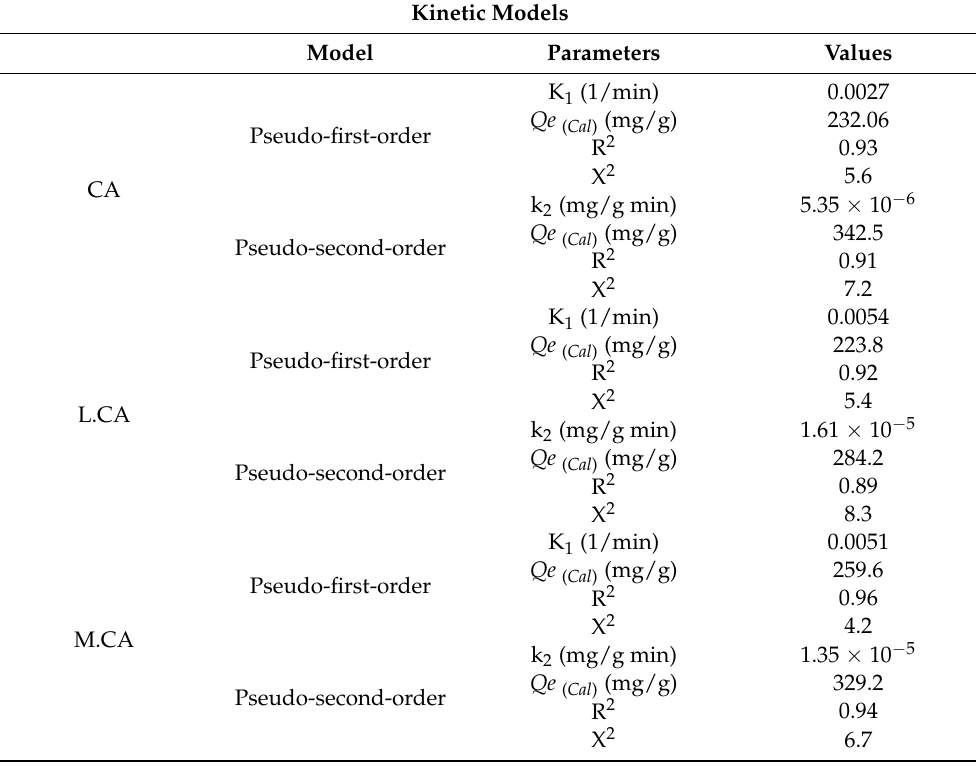
Table 1. The mathematical parameters of the studied kinetic